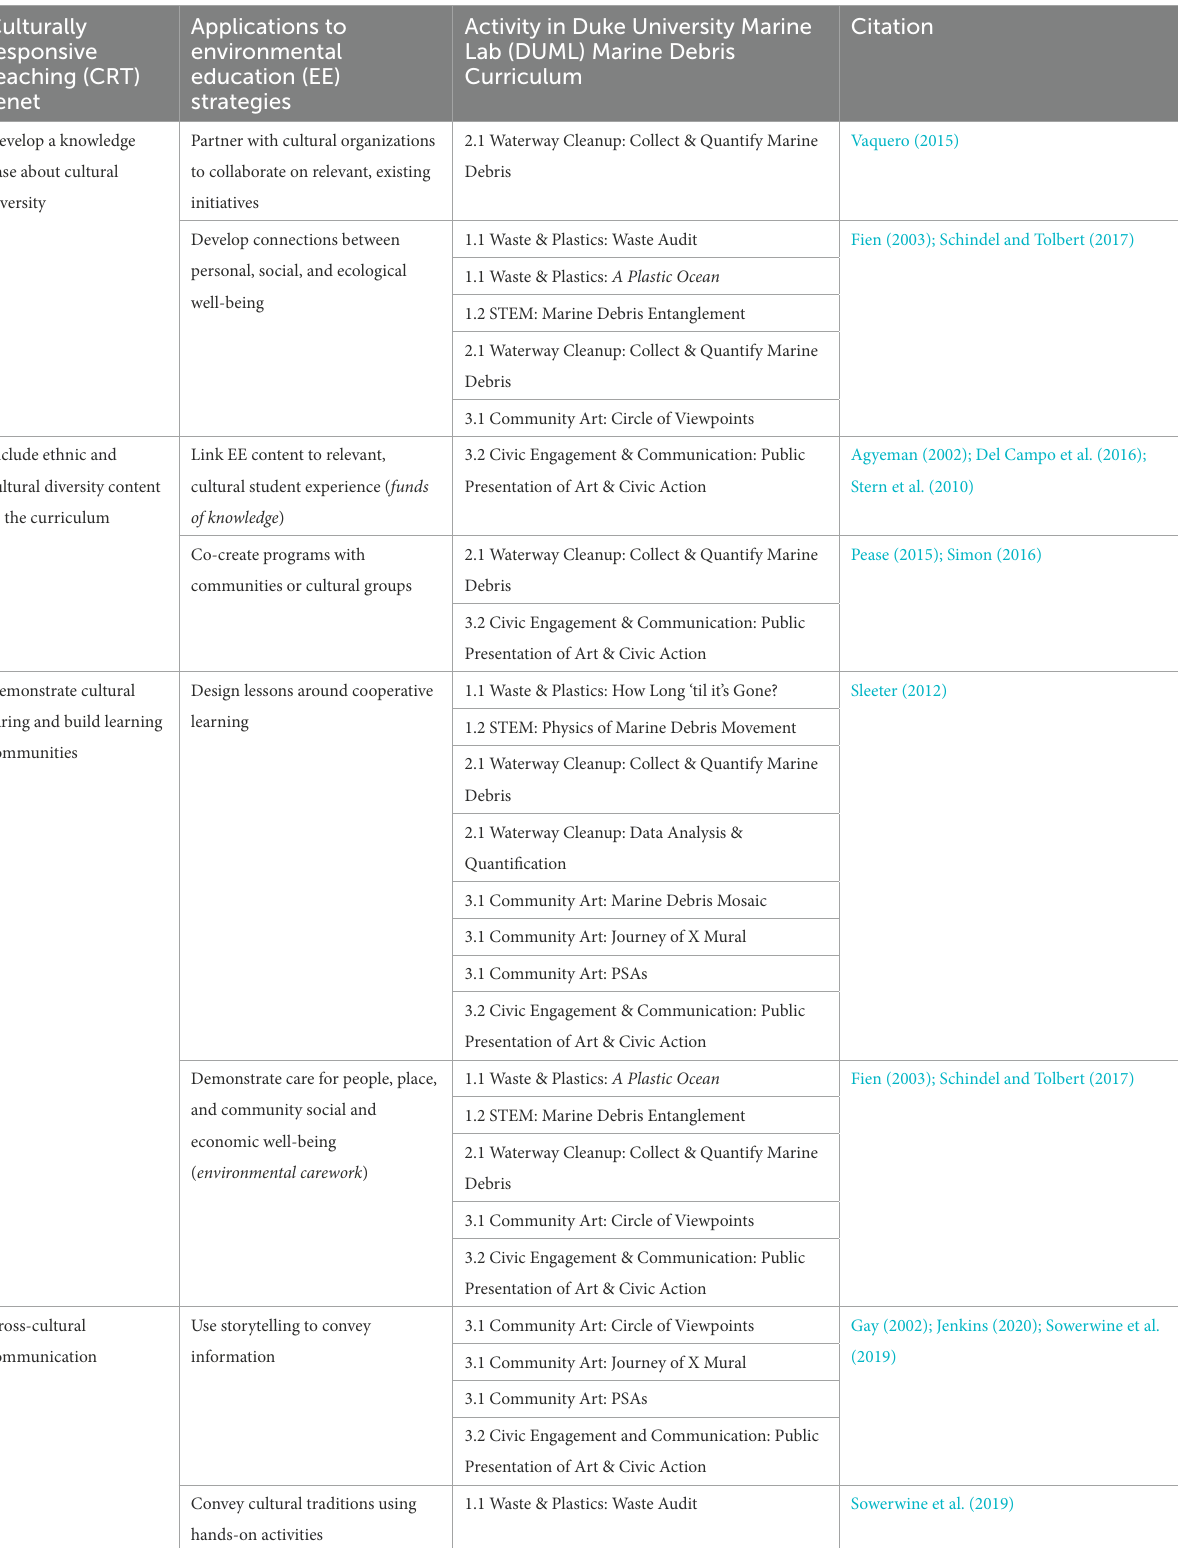
TABLE 1 Elements of Duke University Marine Lab (DUML) Marine Debris Curriculum that match culturally responsive teaching tenets and environmental education (EE) elements as drawn from Pownall, 2022. The DUML Marine Debris Curriculum is freely available online: https://sites. duke.edu/communityscience/files/2020/06/DUML-Marine-Debris-Curriculum2020.pdf Culturally